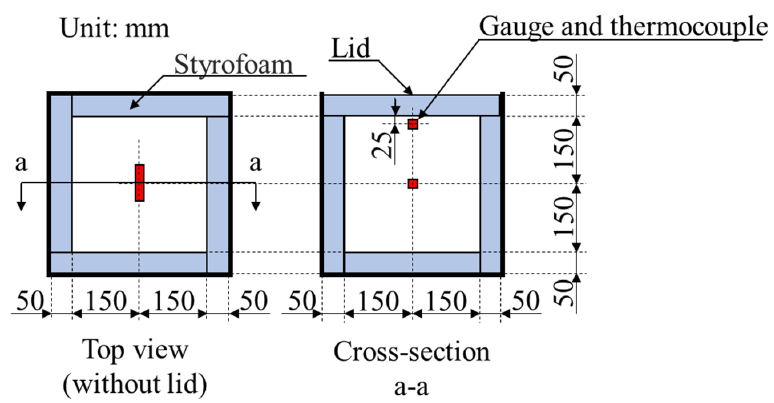
Figure 2. Outline of massive concrete specimen.